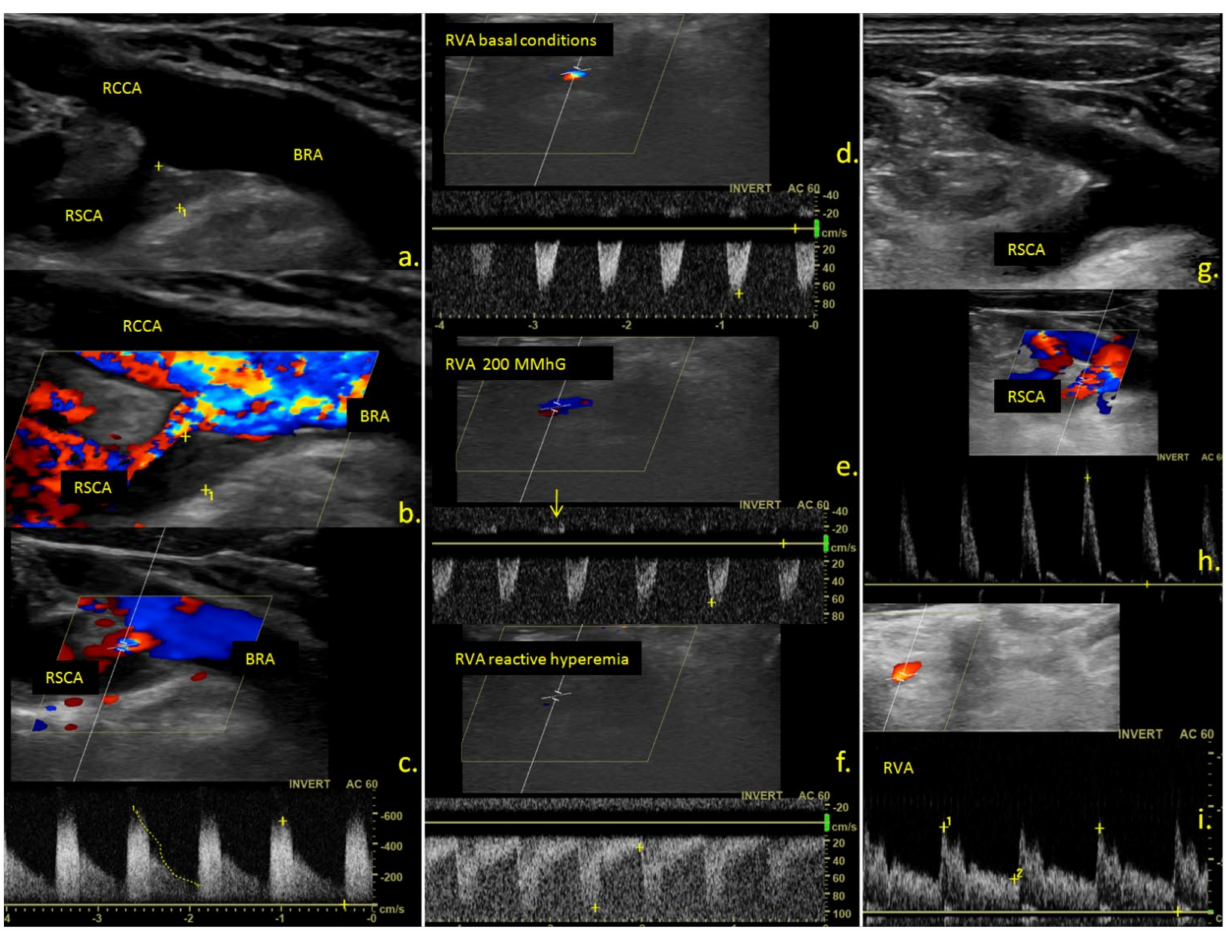
Figure 1. Ultrasound examination of the cervical vessels. ( a ) B-mode; ( b ) color mode; ( c ) triplex mode ultrasound examination revealing a hypoechoic atherosclerotic plaque at the origin of the right subclavian artery leading to severe stenosis. ( d – f ) triplex mode examination of the right vertebral artery in basal conditions ( d ) during compression of the right arm ( e ) and reactive hyperemia ( f ) revealing negative midsysolic and no diastolic flow in basal conditions ( d ); the appearance of a minimal positive dyastolic flow during the compression of the arm (( e ), arrow) and complete flow inversion during the entire cardiac cycle during reactive hyperemia of the arm ( f ); ( g – i ) ultrasound examination after balloon angioplasty of the right subclavian artery, revealing a significant reduction of the grade of stenosis. (( g ) B-mode image, ( h ) triplex mode image, showing a normal triphasic subclavian waveform), and a normal, anterograd flow in the right vertebral artery ( i ). RCCA—right common carotid artery, RSCA—right subclavian artery, BRA—brachiocephalic artery, RVA—right vertebral